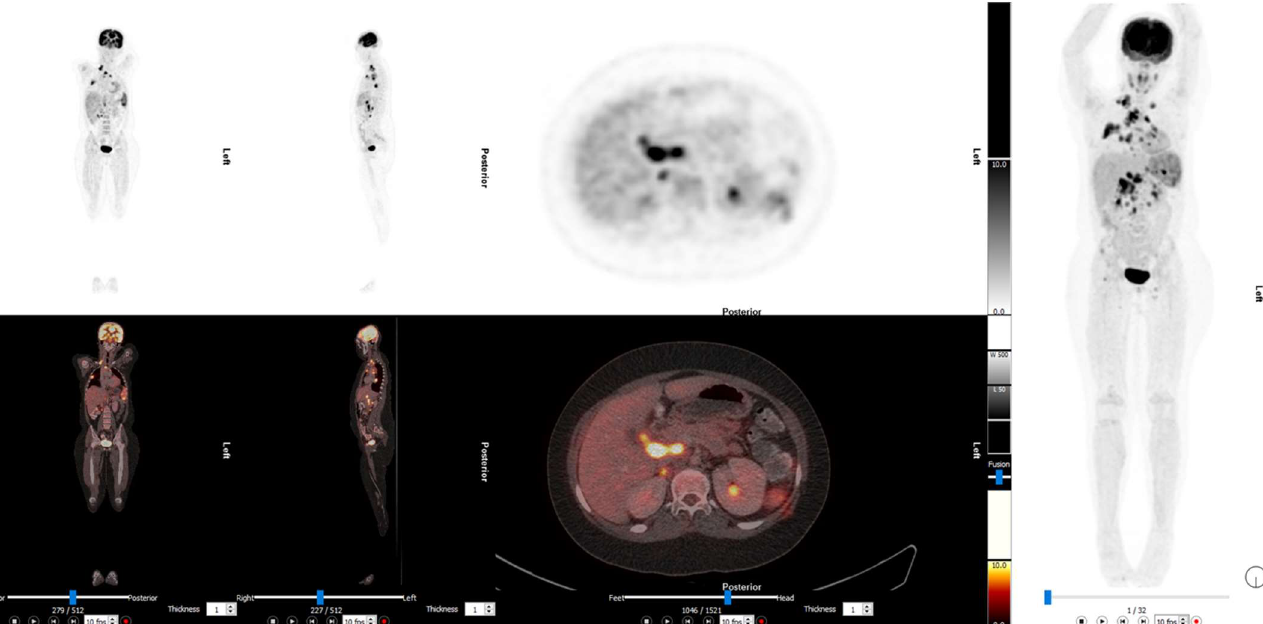
Figure 5. Restaging 2-[ 18 F]FDG PET/CT images of a 12-year-old girl previously treated for Rosai– Dorfman disease. There is extensive abnormal lymph node uptake. Histology of one of the lesions revealed extra-pulmonary TB mimicking Rosai–Dorfman disease.